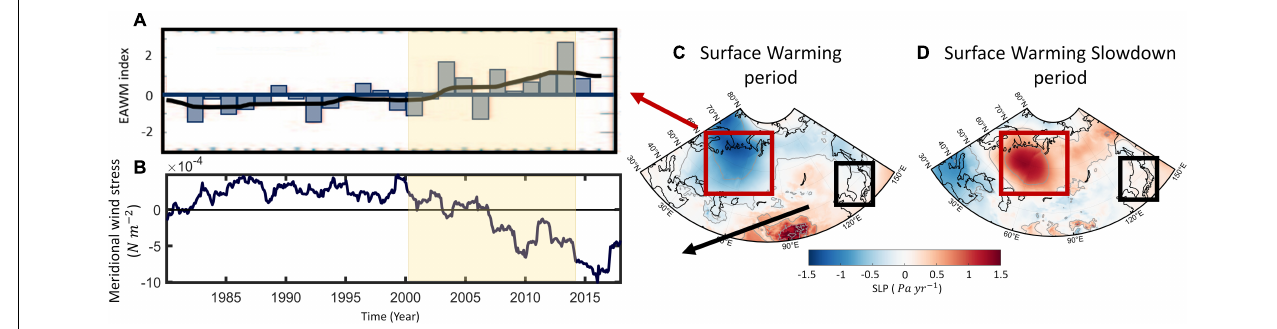
FIGURE 9 | (A) East Asian Winter Monsoon Index (EAWM) (cited from Ding et al., 2014). (B) Meridional wind stress in the ES from 1979 to 2017 and sea level pressure trend of the Northern Hemisphere during (C) 1985–1999 (left), (D) 2000–2014 (right), respectively. Red boxes indicate the Siberian High region. Black boxes indicate the